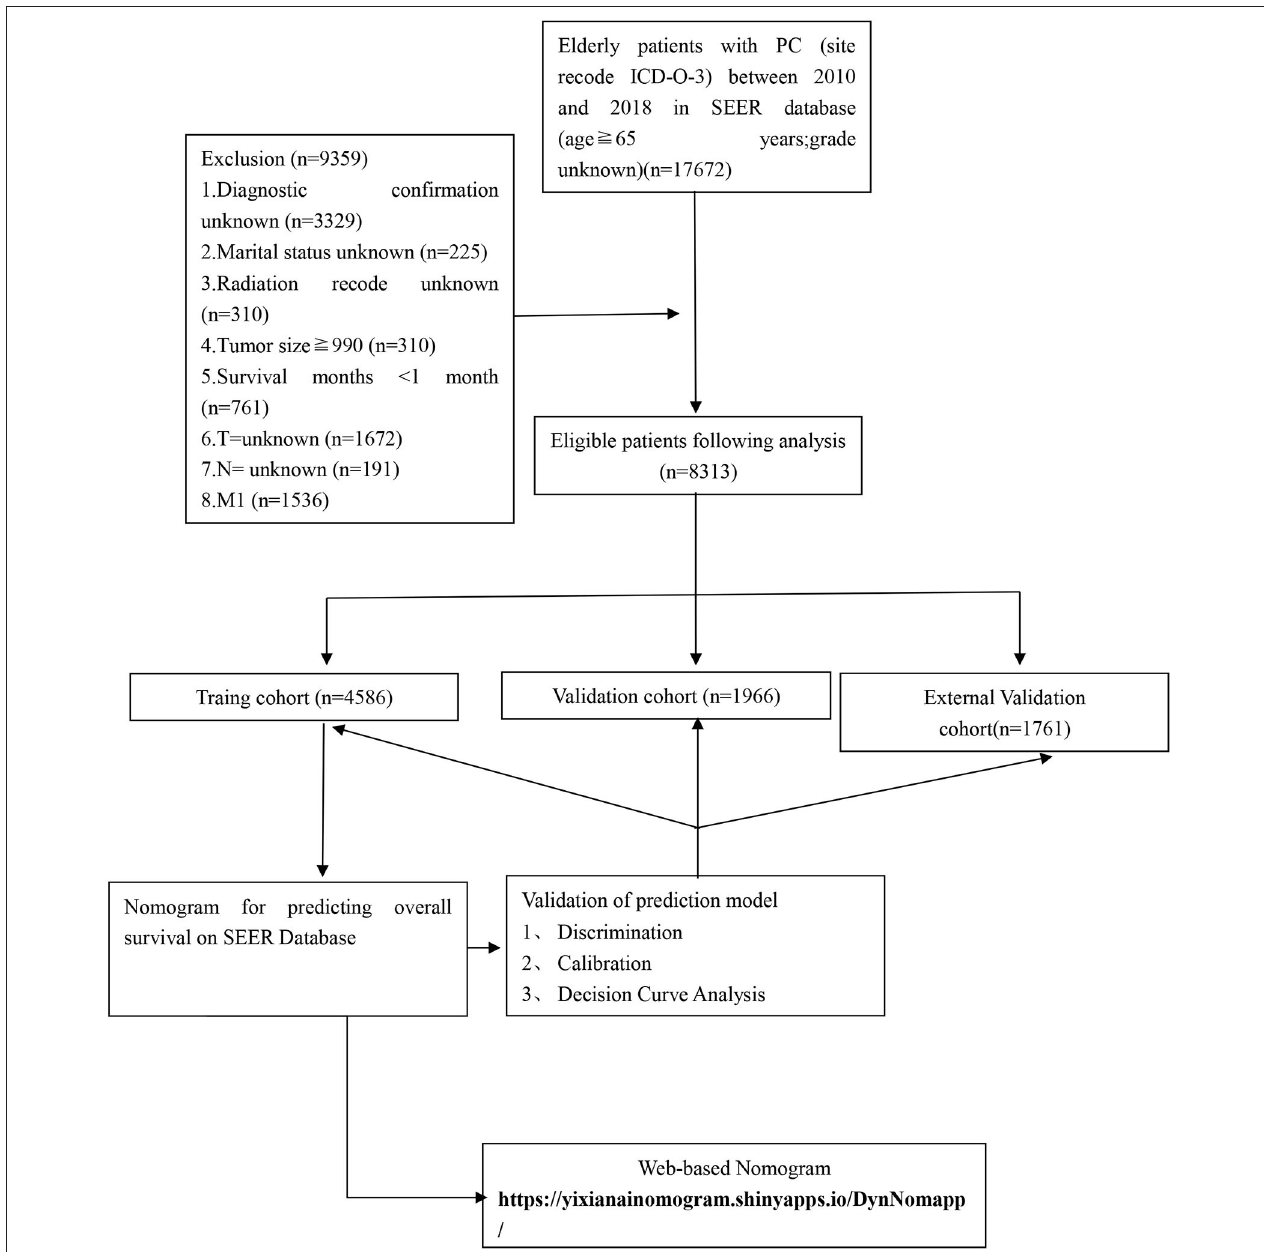
FIGURE 1 | The flowchart of including and dividing patients. Github: https://github.com/xiaoyang11223/pancreatic-cancer.git.